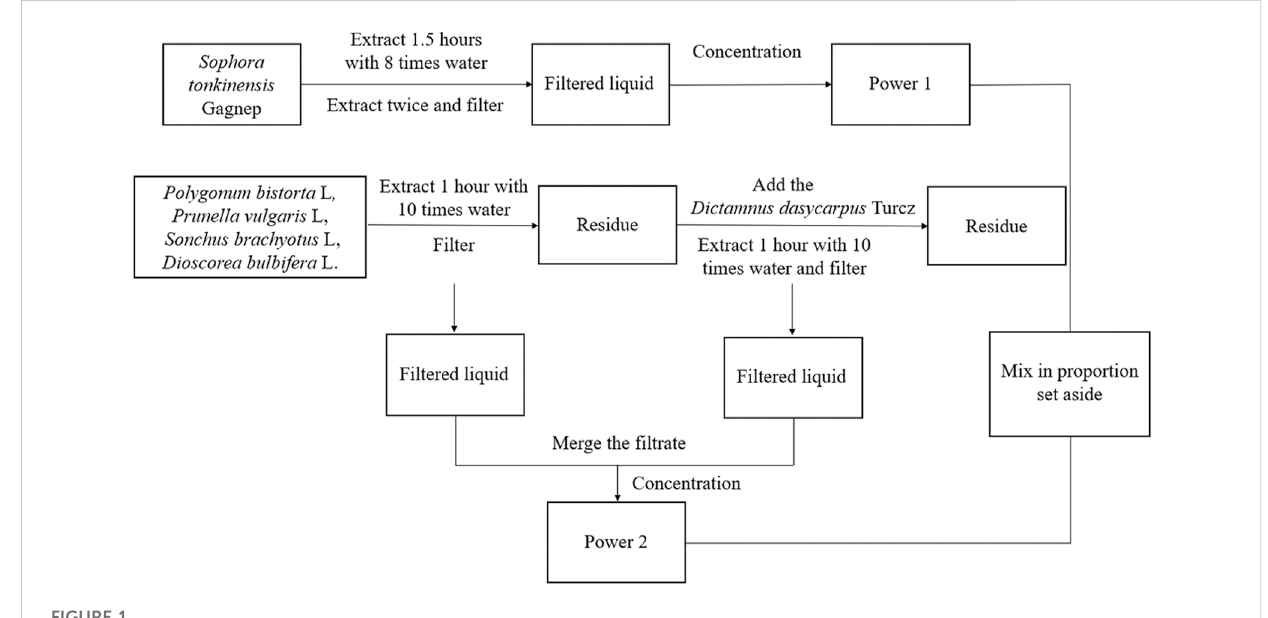
FIGURE 1 Extraction fl ow chart of